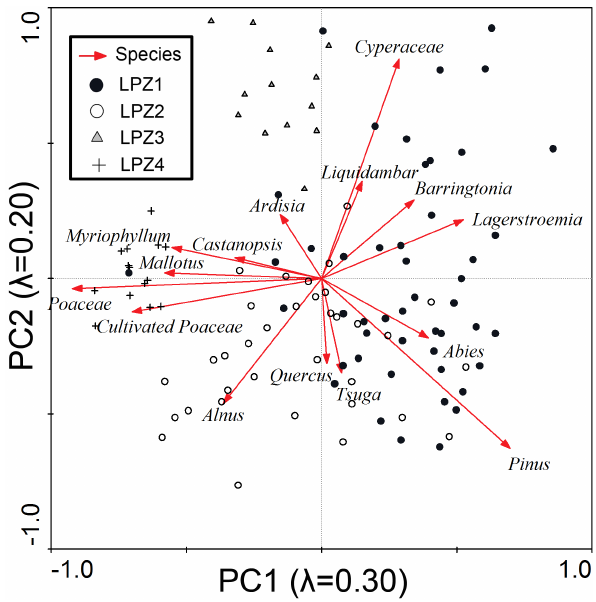
Figure 7. Pollens and diatoms based reconstruction of flood events, typhoon frequency, and human activities during the last 1900 years. Variations of pollen concentrations, diatom concentrations, Pollen PC2, the sum of illite and muscovite, percentages of Lagerstroemia pollen, ratio of planktonic/benthic diatom, grain size (Chen et al., 2012), Pollen PC1, percentage of cultivated Poaceae in DHL, and the sedimentation rate in DHL and SOT on the basis of pollen zones